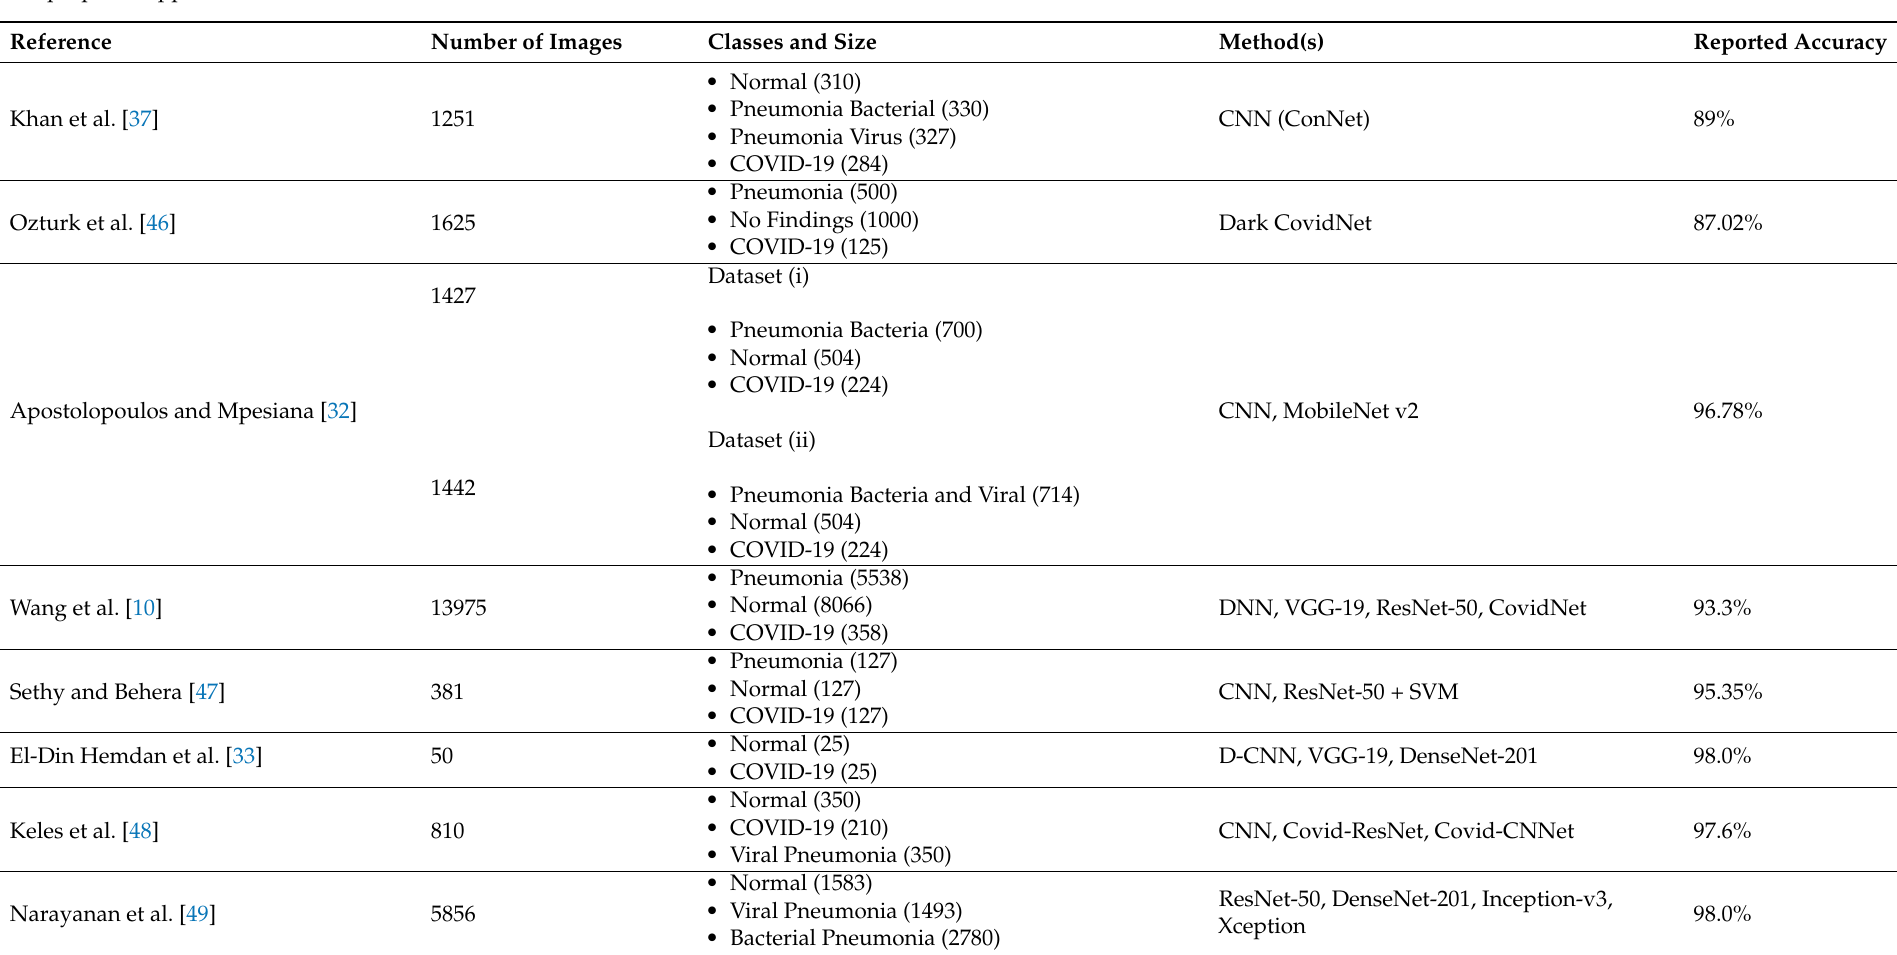
Table 1. Presents a survey of proposed COVID-19 chest X-ray classification and/or detection methodology, the dataset(s) used in the research, and reported accuracy for the proposed